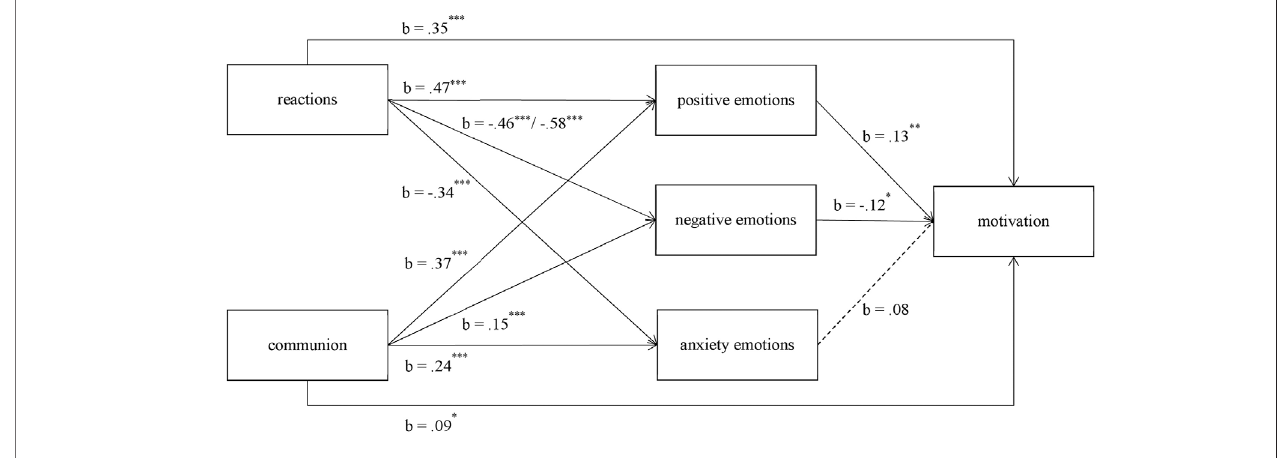
FIGURE 1 | Results of the modi fi ed path model (H3 and